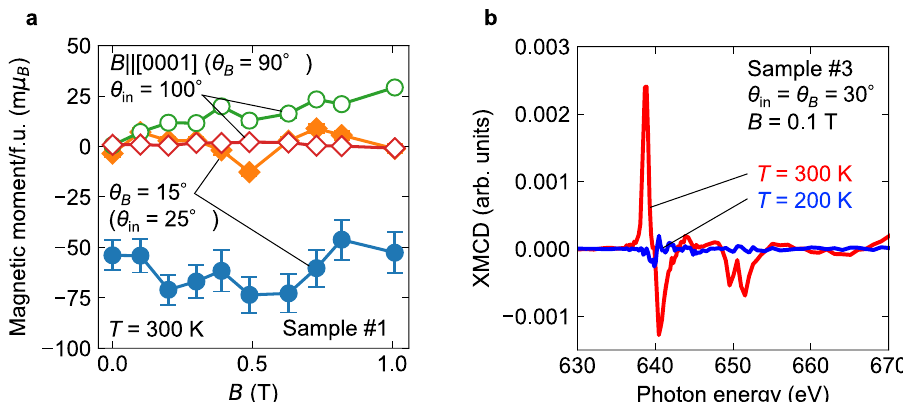
Fig. 3 XMCD sum rule analysis and temperature dependence of XMCD spectra. a Magnetic moments in Mn 3 Sn obtained from sum rule analyses for θ B = 15° (solid symbols) and B ||[0001] (open symbols), respectively. Circles and diamonds correspond to the magnetic moments of m S Relatively large errors in m S for θ B = 15° are determined from the uncertainty of XMCD integration by the oscillating behavior above ~655 eV, which is eff observed only for θ B = 15°. b XMCD spectra for T = 300 K and 200 K. The XCMD intensity of Fig. 3b (sample #3) is almost 1.5 – 1.7 times smaller than that of Fig. 2a (sample #1). Although the origin of intensity variation is not clear, might be arising from extrinsic difference of sample conditions including surface contaminations and/or distinct sample batch.